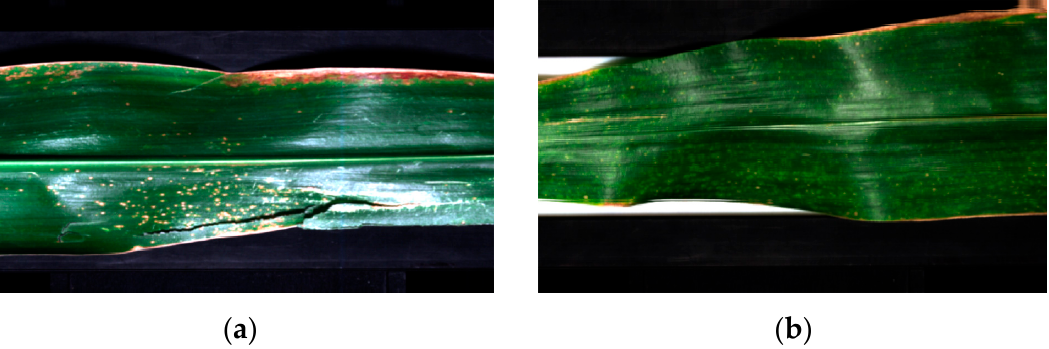
Figure 3. Pre–process results of hyperspectral images of two diseases. ( a ) Anthracnose image after SG processing; ( b ) Brown spot image after SG processing.